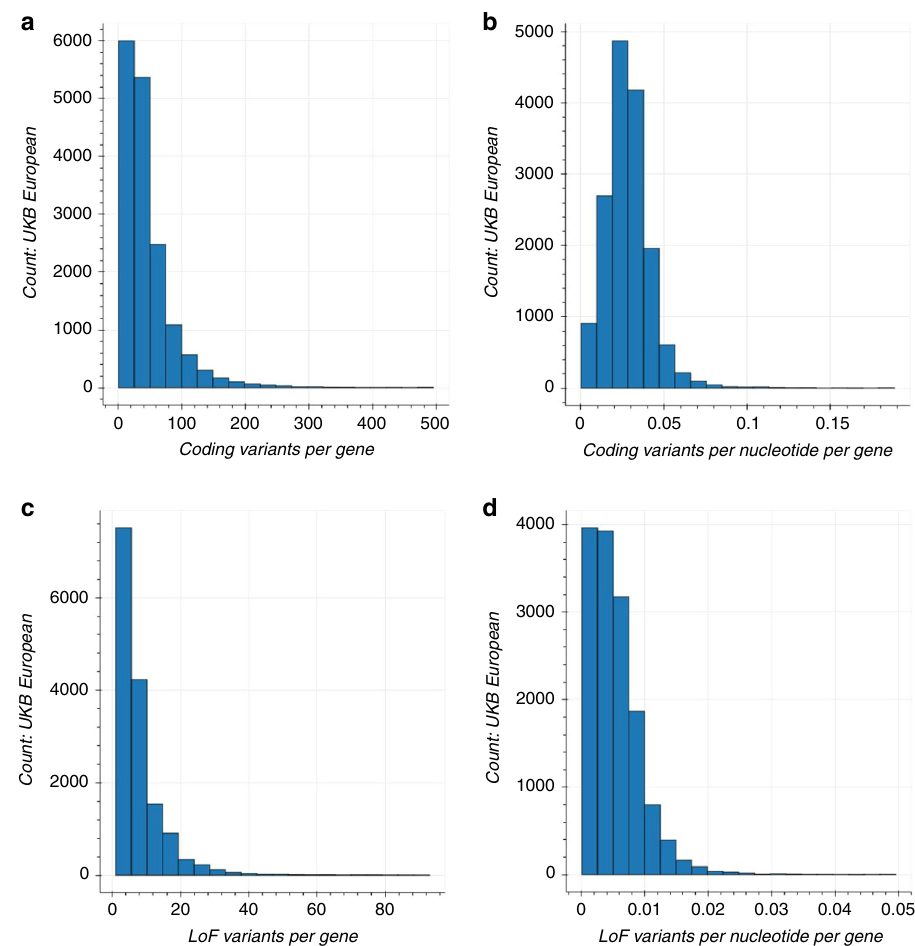
Fig. 2 Histogram of number of qualifying variants per gene in European UKB cohort. a Number of qualifying coding variants per gene. Eleven genes with >500 variants were excluded from plot. The median of variants per gene is 34 (range [1:2833]). b Number of qualifying coding variants per coding nucleotide of each gene. Sixteen genes with values >0.2 were excluded from the plot. The median of variants per nucleotide is 0.027 (range [0.0001:0.991]). c Number of qualifying loss of function (LoF) variants per gene. Six genes with >50 variants were excluded from plot. The median of variants per gene is six (range [1:178]). d Number of qualifying LoF variants per coding nucleotide of each gene. Nine genes with values >0.05 were excluded from the plot. The median of variants per nucleotide is 0.005 (range [9.5 × 10 − 5 :0.25]). Plots for all ancestries and HNP cohort can be found in Supplementary Fig.